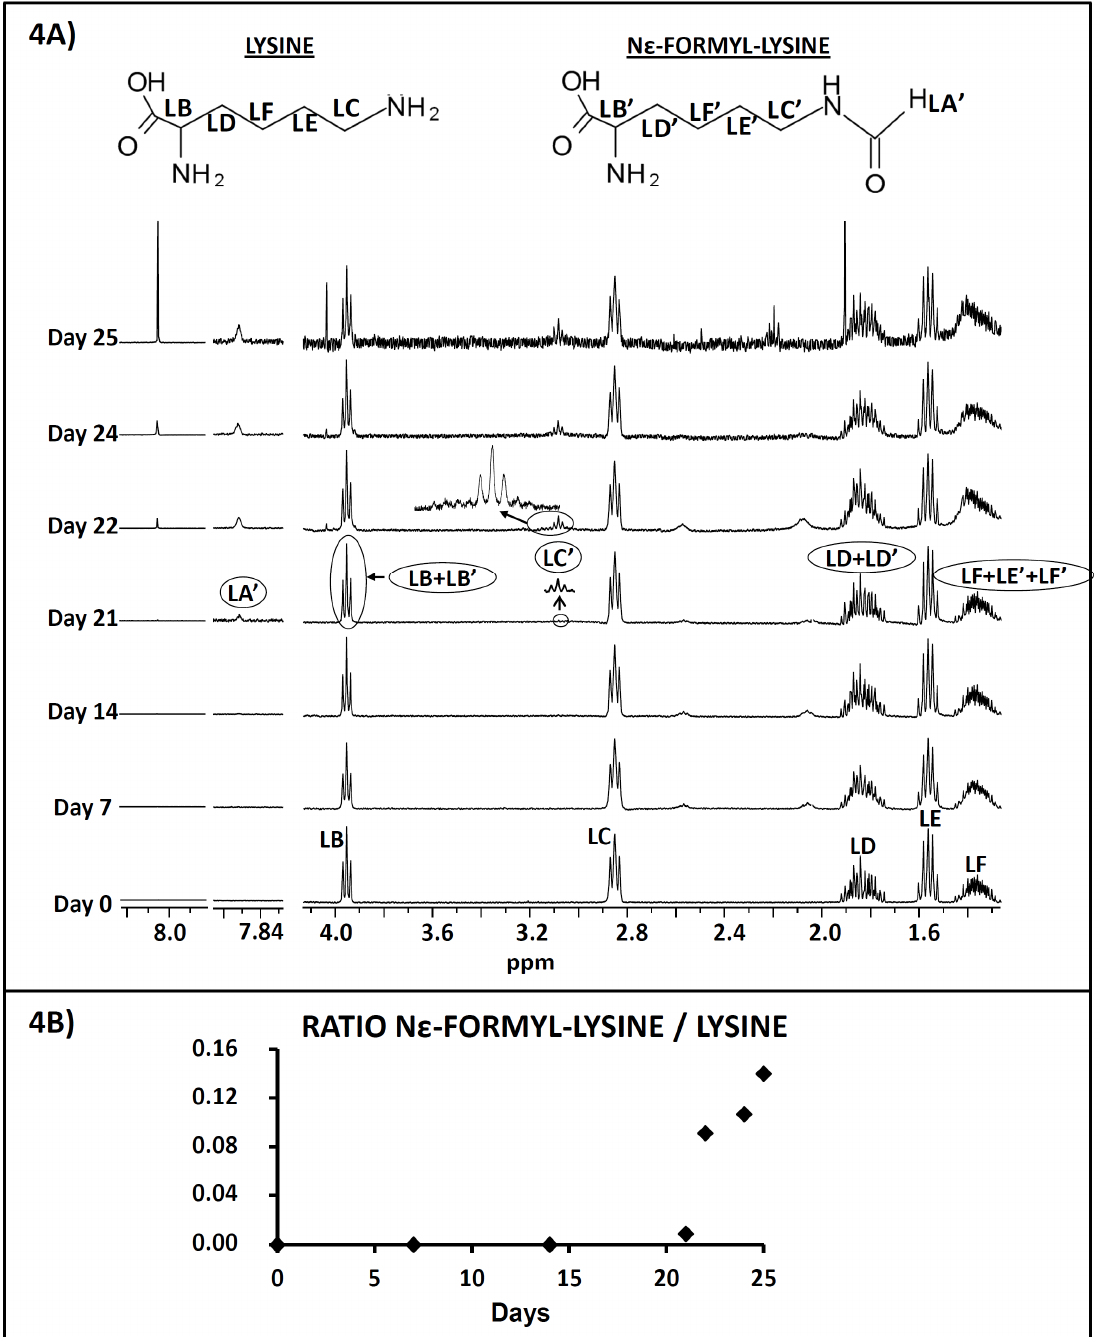
Figure 4. ( A ) 1 H NMR spectrum of the aqueous extract of the RSO + 2LYS sample before being heated (day 0), and its evolution throughout the oxidation process. Letters agree with those in